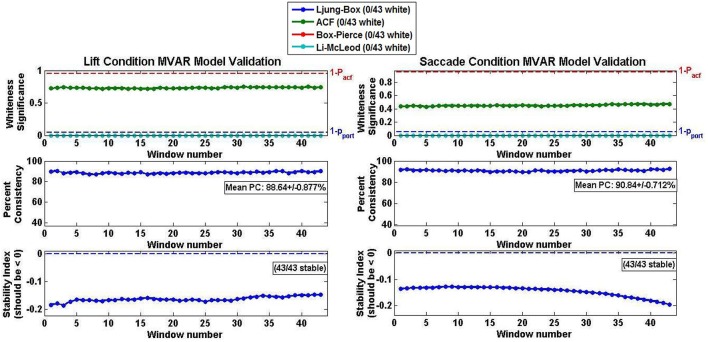
Model validation criteria for Lift (left) and Reach/Saccade (right) Conditions averaged across all 10 subjects. Whiteness of AR model residuals (top row) evaluated using Autocorrelation function (ACF) and three different Portmanteau tests. None of the MVAR models passed any of the whiteness tests, suggesting that none of the models captured adequately the modeled temporal dynamics. Percent consistency (middle row) indicates percent of correlational structure of original data captured by the model. Percent consistency was uniformly high as its values were in the order of 90% with small standard deviations. Stability index (bottom row) is log of largest eigenvalue of AR model. Negative index implies that largest eigenvalue is less that one, and thus, the MVAR models were stable. Note, that all tests were conducted individually for every sliding window (43 in total) across the epoch, hence the 43 data points in each graph.